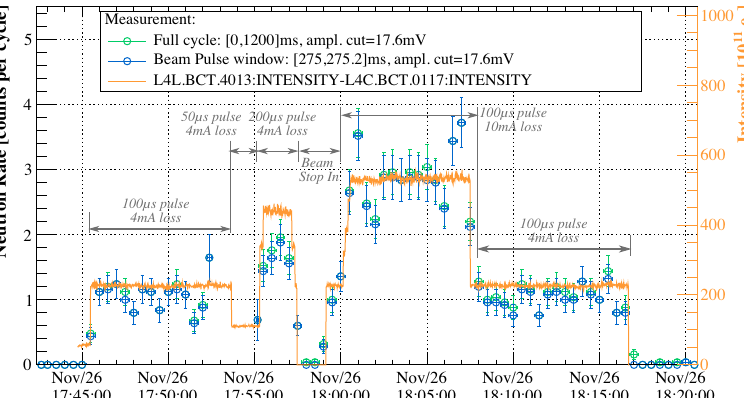
FIG. 17. Estimated neutron rates (green and blue) during controlled loss experiment together with the differential BCT signal (orange). See text for details.